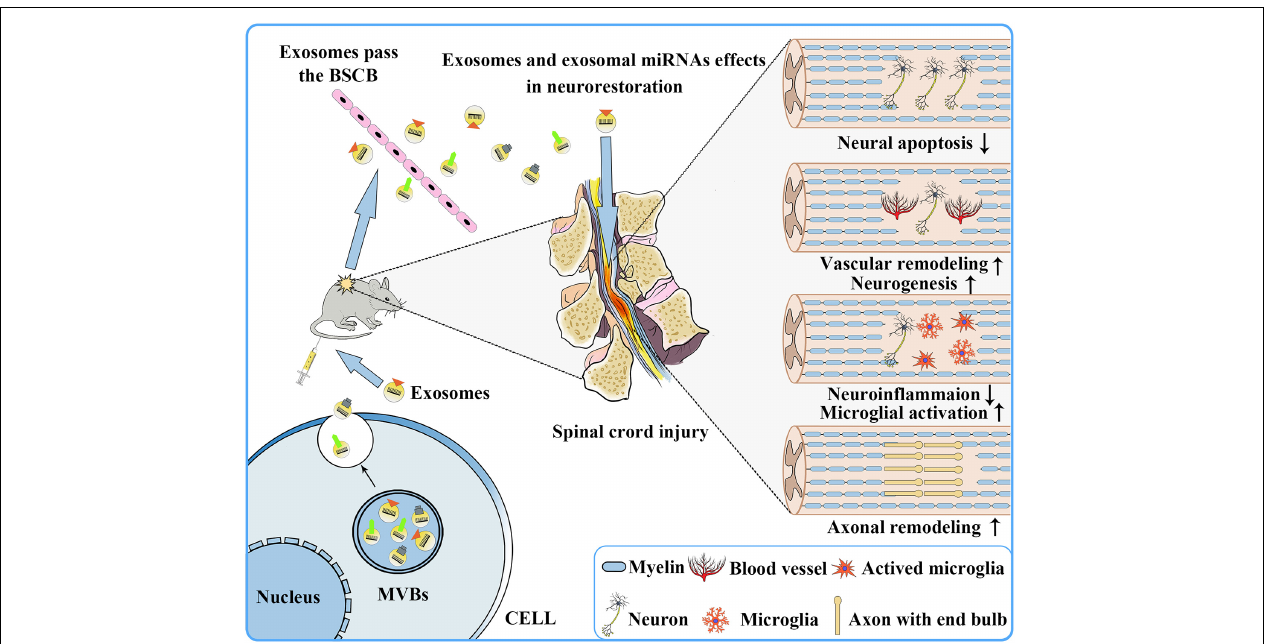
FIGURE 3 | Repair of the nervous system following SCI after exosome transplantation. Exosomes secreted by donor cells can freely pass through the blood–brain barrier and play a role in promoting nervous system repair, including reducing neuronal apoptosis, promoting vascular remodeling and neurogenesis, reducing neuroinflammation, and promoting microglia activation and axonal